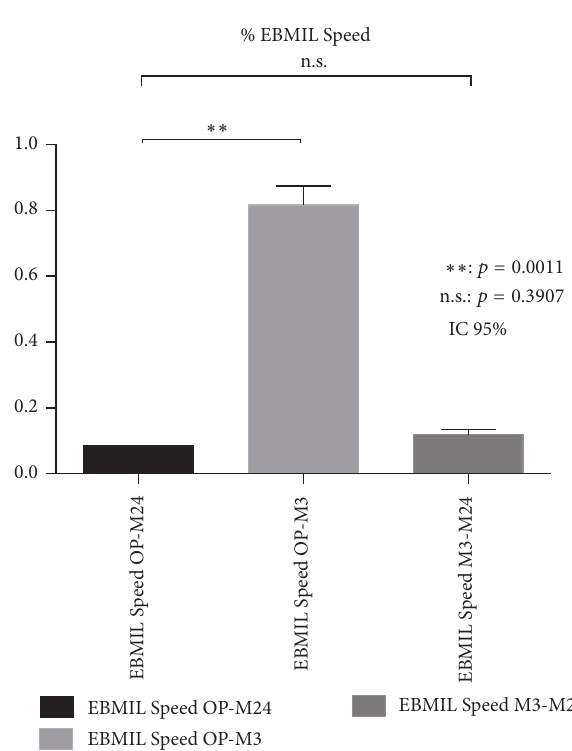
Figure 3: Comparison of Excess Body Mass Index Loss (% EBMIL) speeds between operative time-M3 and operative time-M24. EBMIL: Excess BMI Loss; OP-M3: time interval between operative time and 3rd month; OP-M24: time interval between operative time and 24th month; M3-M24: time interval between 3rd month and 24th month. EBMIL speeds are compared using the paired 𝑡